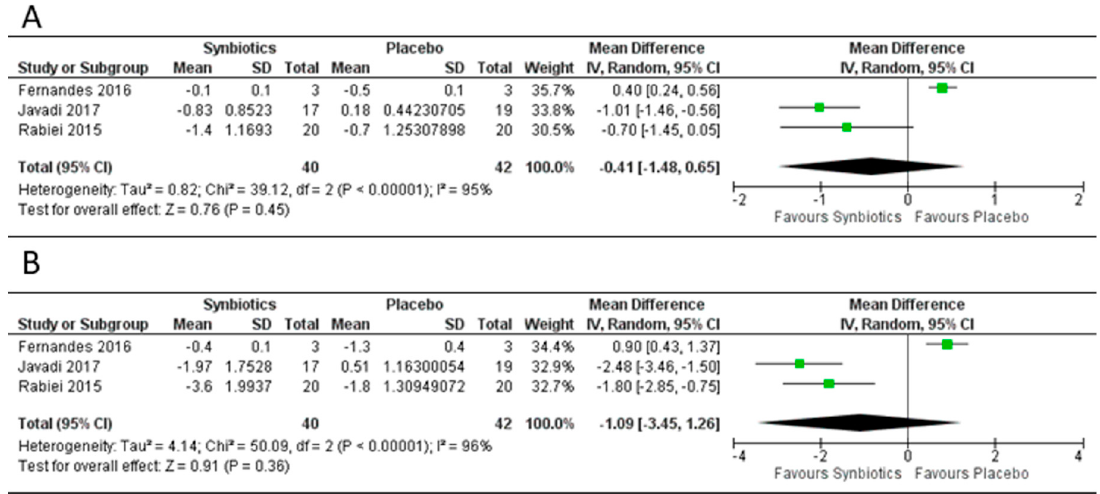
Figure 6. Forest plot of effect of synbiotics on: ( A ) BMI; ( B ) body weight. Data synthesis using the random effects model for the mean differences in BMI and body weight for the included randomized controlled trials of synbiotics versus placebo. There was no significant reduction in BMI or body weight in the three studies (Figure 6A,B).